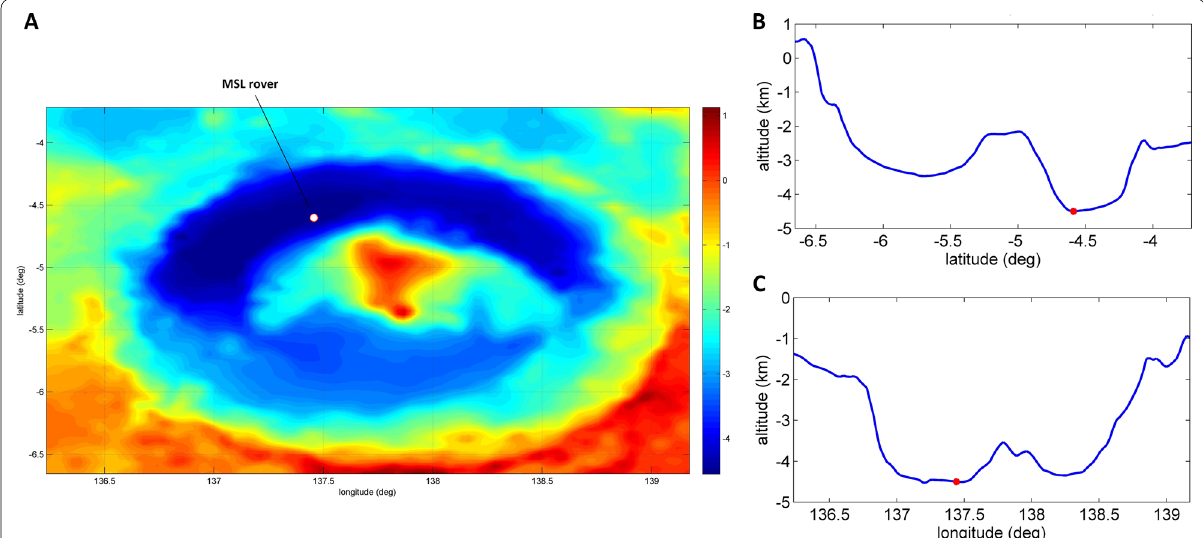
Fig. 5 A Topographic region around the Mars Science Laboratory (Gale Crater). Ground altitude is shown in kilometers above the Mars geoid. B , C Topography along the latitude and longitude axes, respectively, passing along the MSL. MSL’s general location is also indicated by a